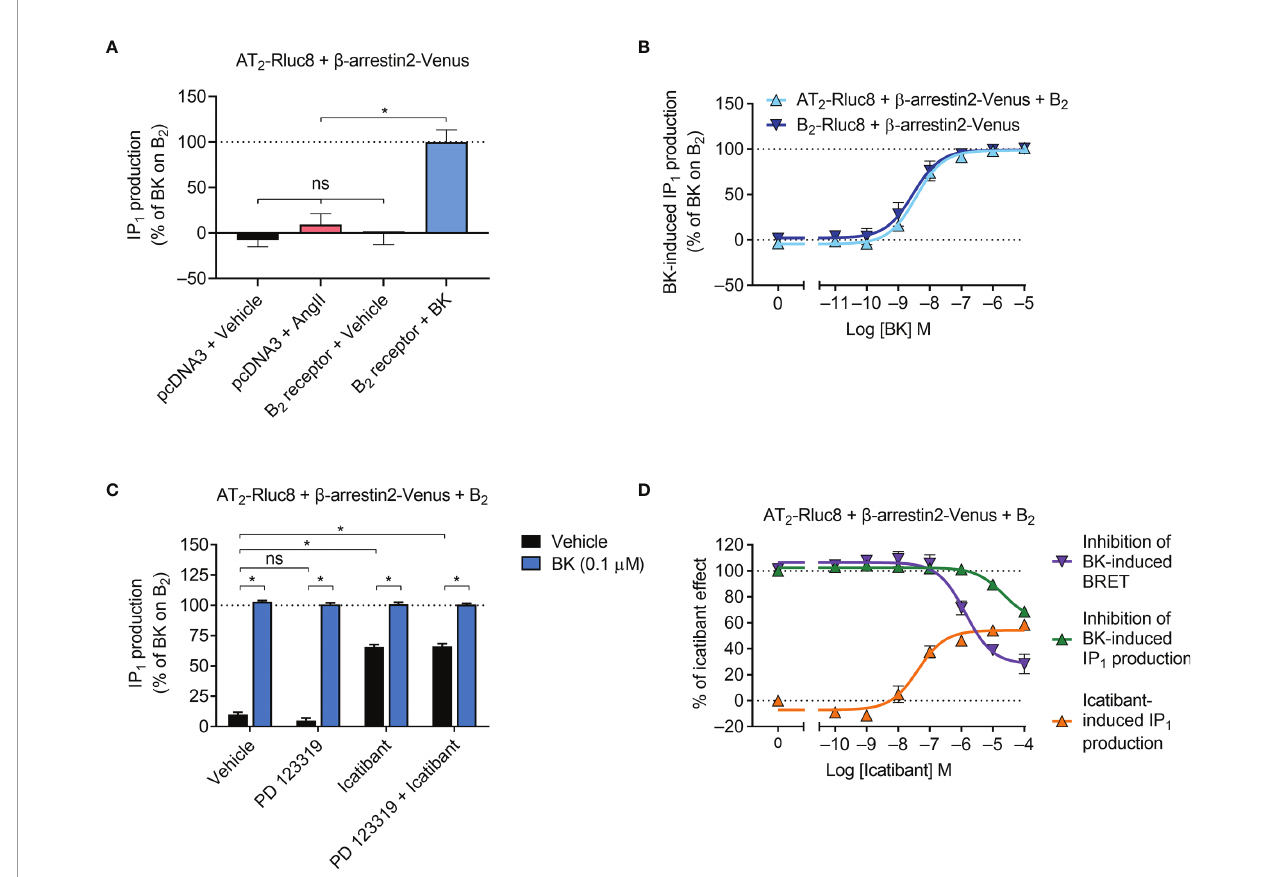
FIGURE 3 | IP 1 signaling by the AT 2 -B 2 heteromer. HEK293FT cells were transfected with plasmid cDNA as described on graphs. (A) Ligand-induced IP 1 signaling in cells expressing AT 2 -Rluc8, with or without the B 2 receptor. *p < 0.05; ns, not signi fi cant (one-way ANOVA with Tukey ’ s multiple comparisons test). (B) Concentration- response analysis showing BK-induced IP 1 signaling. (C) IP 1 assay in the presence of 10 m M antagonists (or vehicle) and 0.1 m M BK. *p < 0.05 (two-way ANOVA with Sidak ’ s multiple comparisons test). (D) Concentration-response analysis comparing agonistic and antagonistic actions of icatibant, the latter antagonizing 0.1 m M BK. All data are presented as mean ± SEM of ≥ three independent experiments performed in duplicate (IP 1 assay) or triplicate